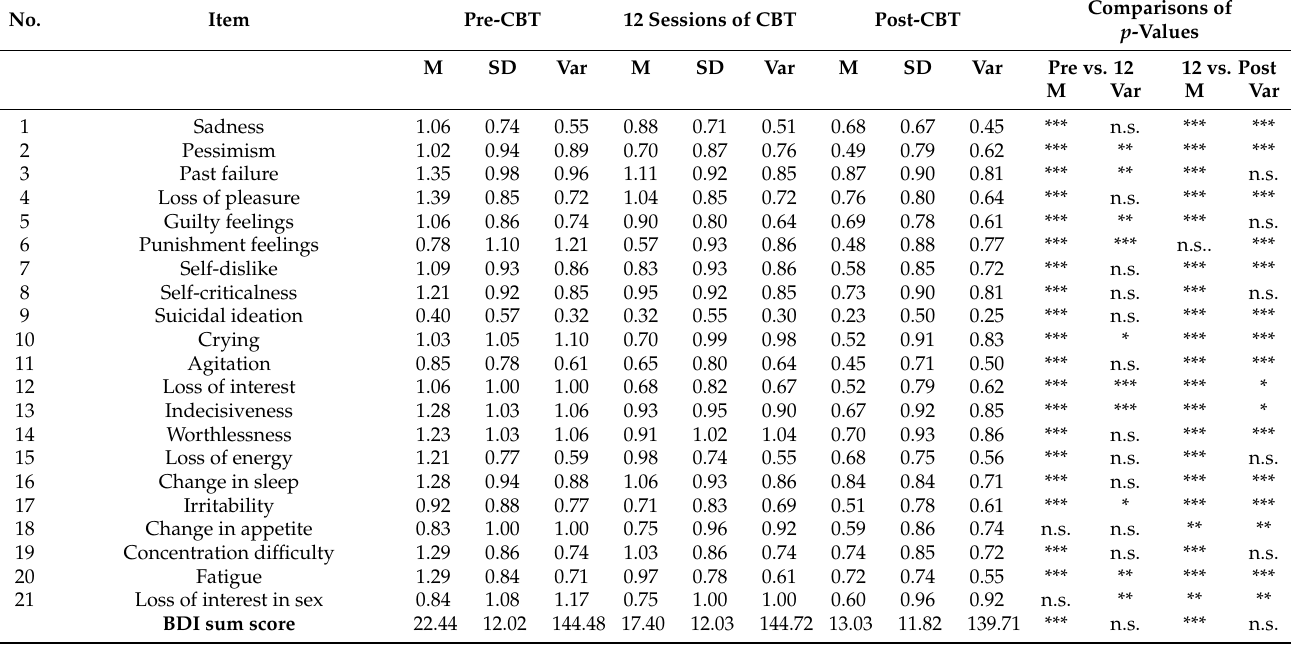
Table 1. Means and standard deviations for all 21 BDI